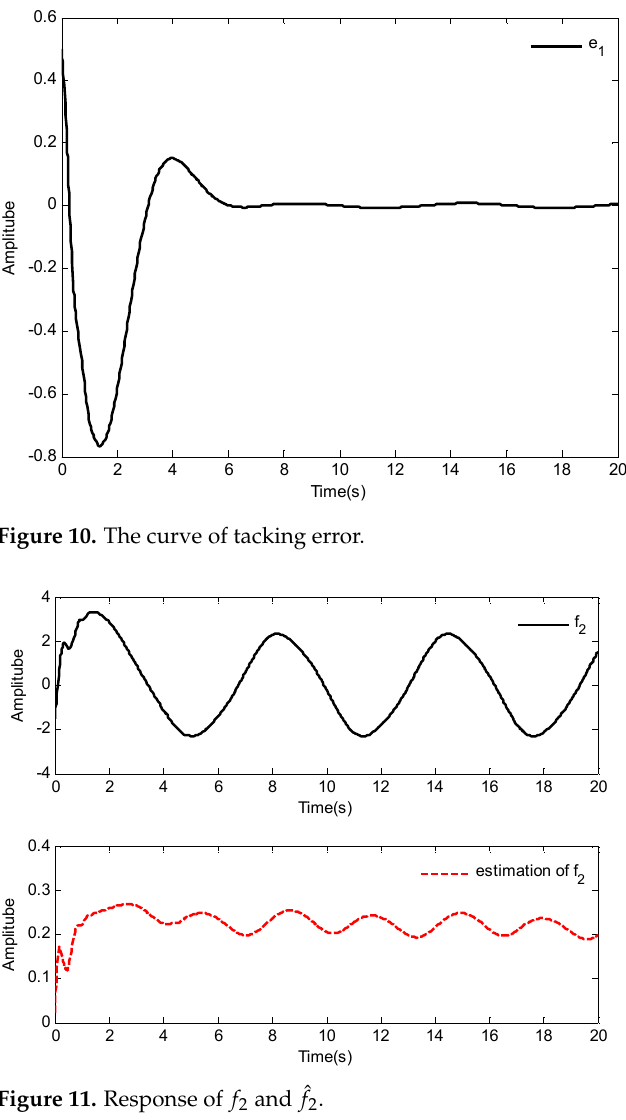
f and 2 f and 2